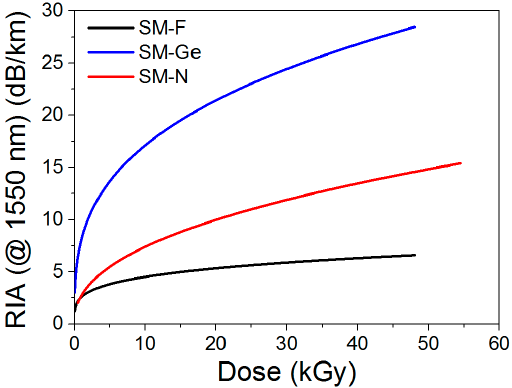
Figure 6. Radiation Induced Attenuation (RIA) of tested fibers at 1550 nm during on-line irradiation (1 kGy/h): SM-Ge (blue), SM-F (black) and SM-N